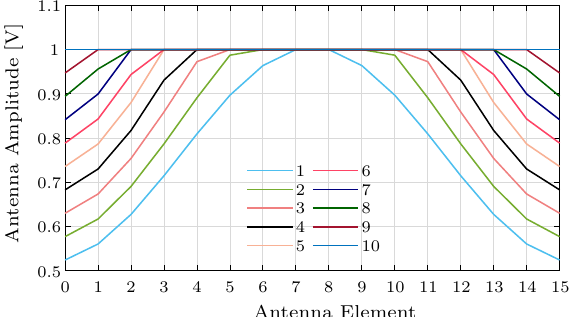
Fig. 7 K 10 chosen amplitude tapers where the sharpest taper is based on a Taylor window. The amplitude = is normalized to the phase shifter corner setting with lowest